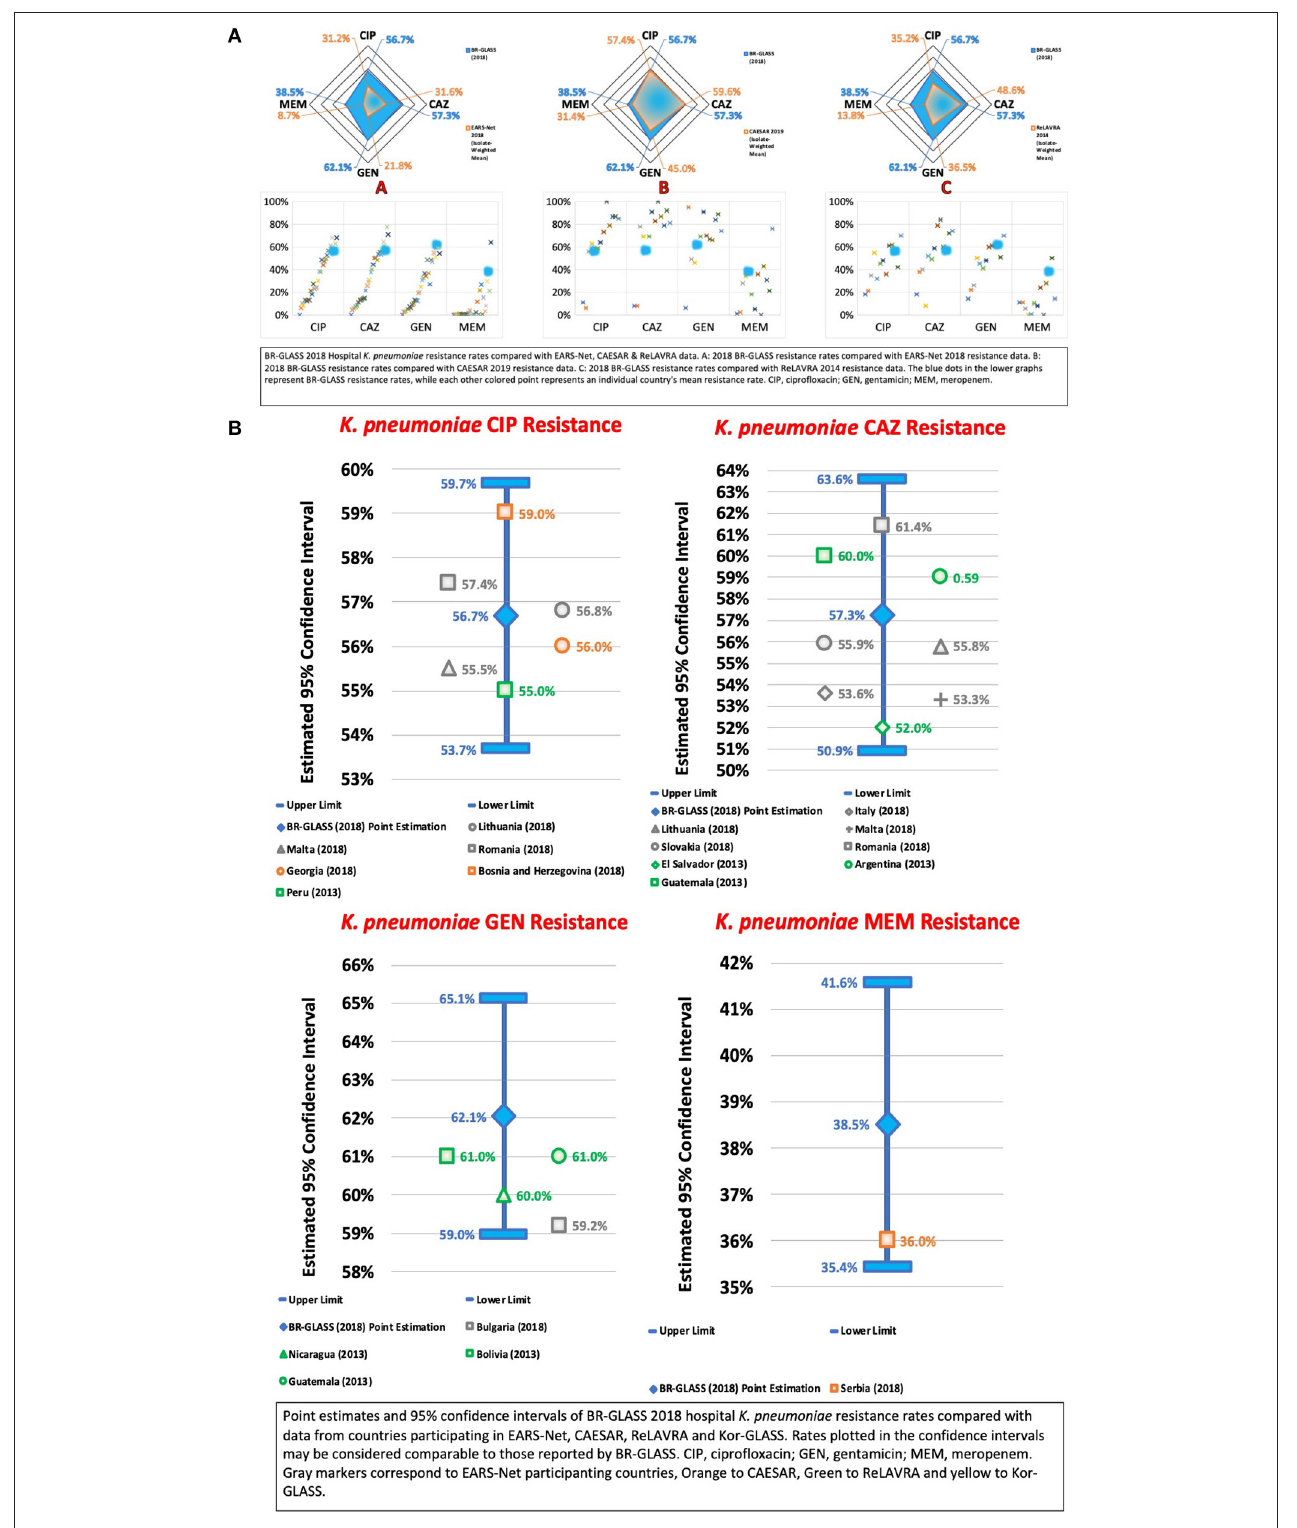
FIGURE 9 | (A) BR-GLASS 2018 Hospital K. pneumoniae resistance rates compared with general EARS-Net, CAESAR, and ReLAVRA data. (B) BR-GLASS 2018 Hospital K. pneumoniae estimated resistance rates with 95% confidence intervals and comparable rates reported in different countries.